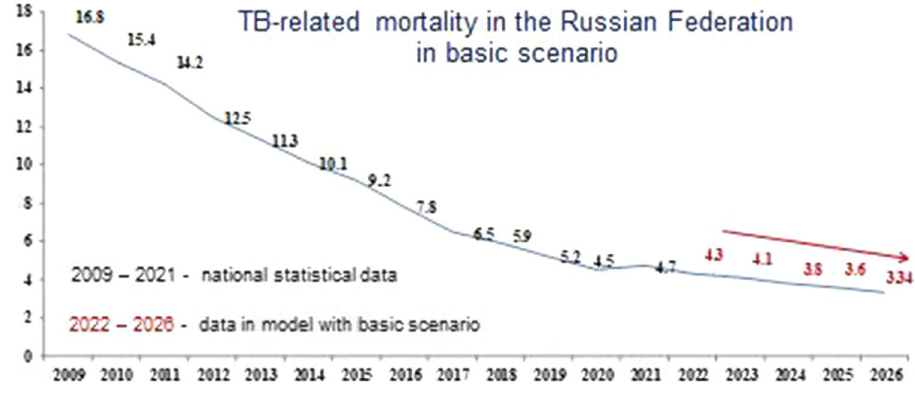
Fig. 8 Forecast of TB-related mortality in the Russian Fed- eration with the conservative